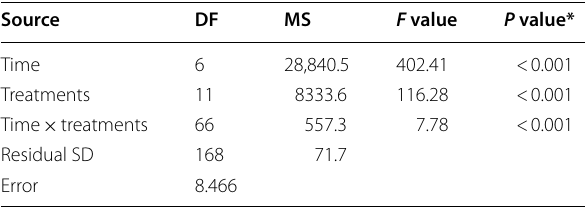
Table 1 Analysis of variance comparison of survival